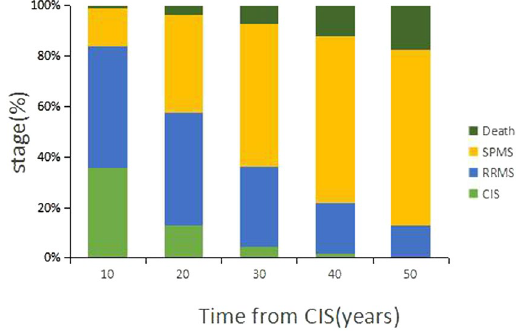
Figure 3. Percentage of the subjects at each of the disease stages at varying time after CIS onset. CIS: clinically isolated syndrome; RRMS: relapsing-remitting multiple sclerosis; SPMS: secondary progressive multiple